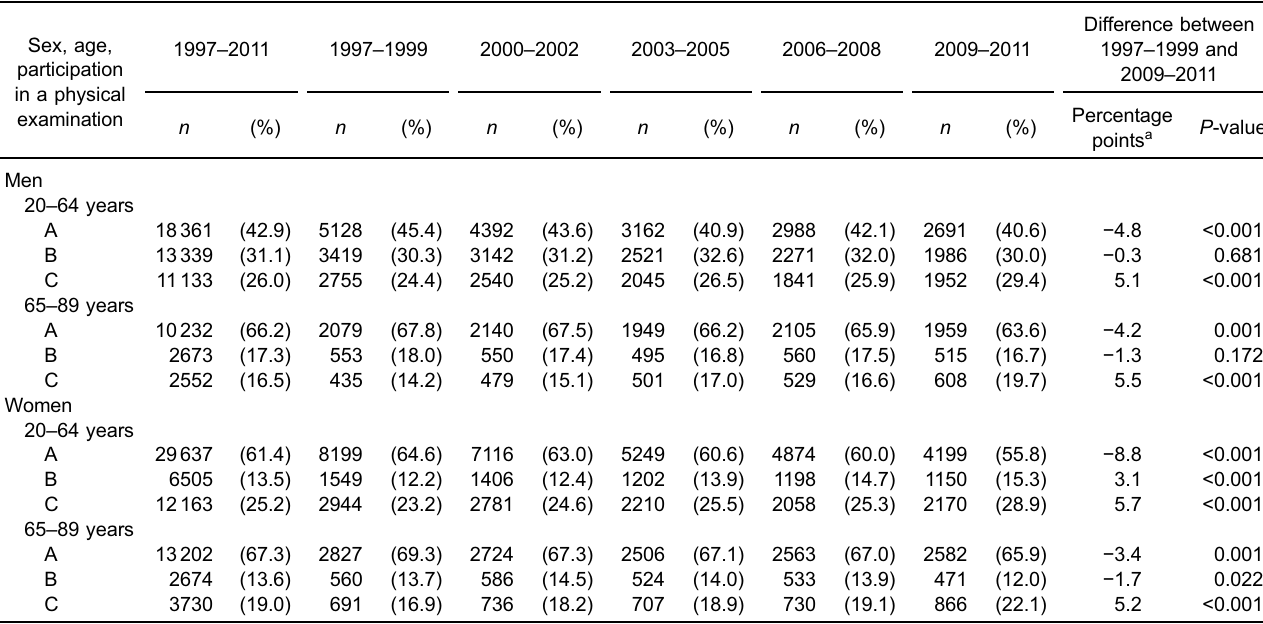
Table 1. Distribution of study subjects by the status of participation in a physical examination, sex, age group, and 3-year survey period Sex, age, participation